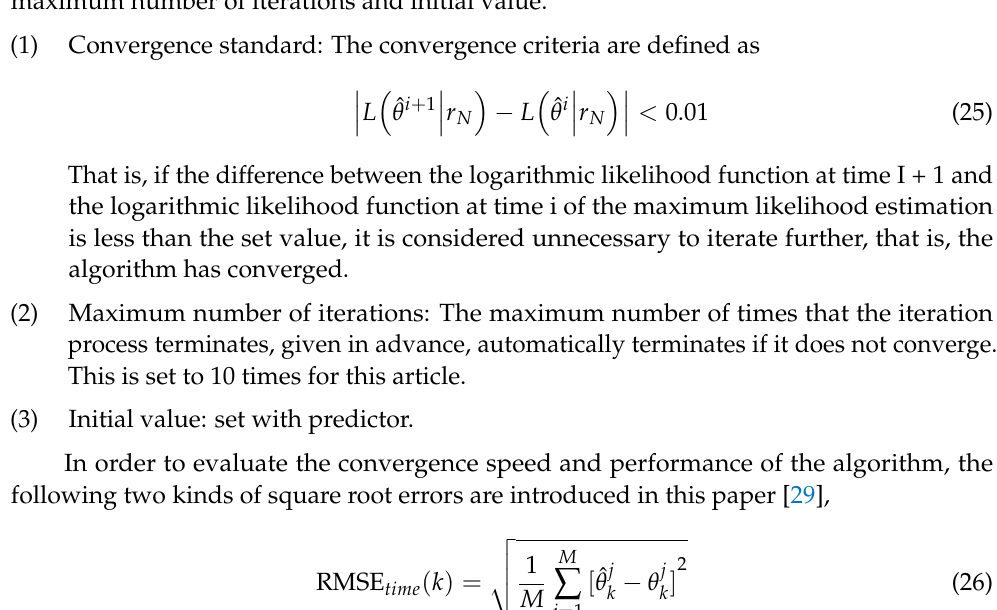
Figure 9. Comparison of the mean values of the VFAPLL (MLE-based), VFAPLL (EKF-based) and FAPLL (MLE-based) RMS Doppler frequency errors under different jerk scenarios when CNR = 23 dB/Hz.